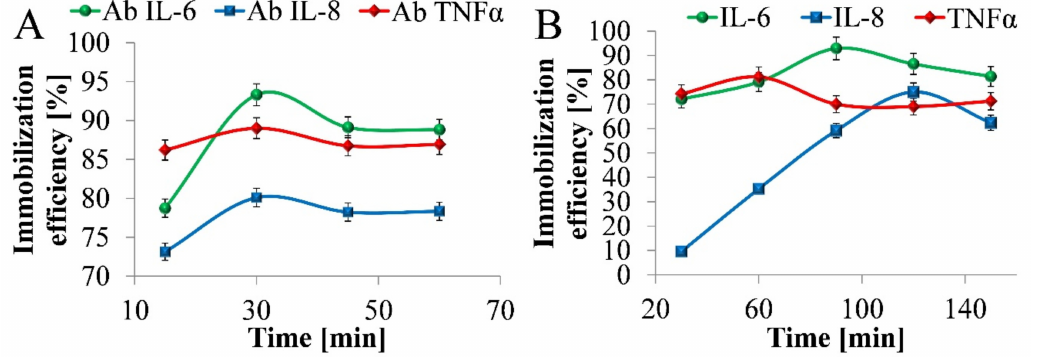
Figure 4. Immobilization e ffi ciency of ( A ) IL-6, IL-8, TNF α antibodies, and ( B ) IL-6, IL-8, TNF α antigen on